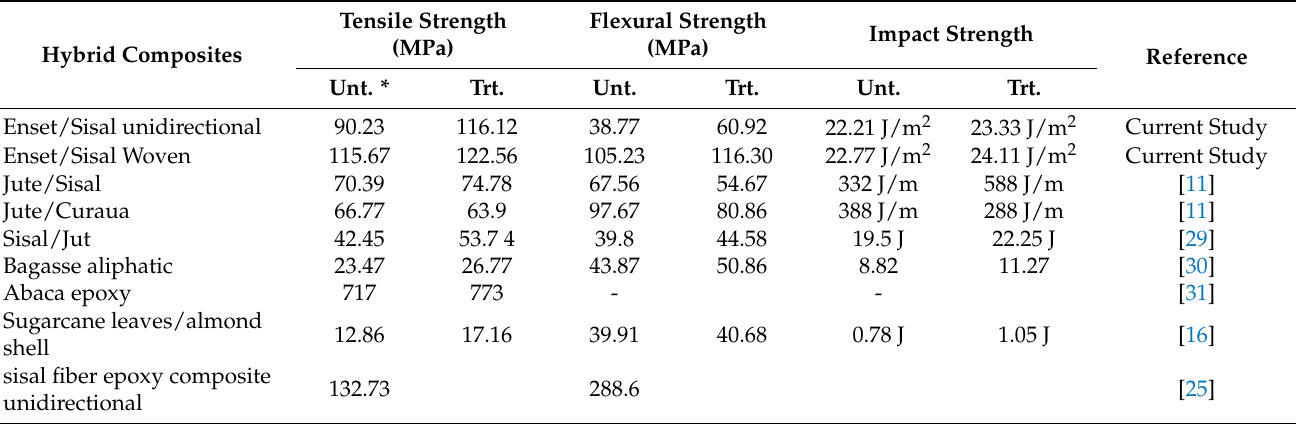
Table 1. Effects of alkali treatment on mechanical behaviors of natural fiber-reinforced hybrid